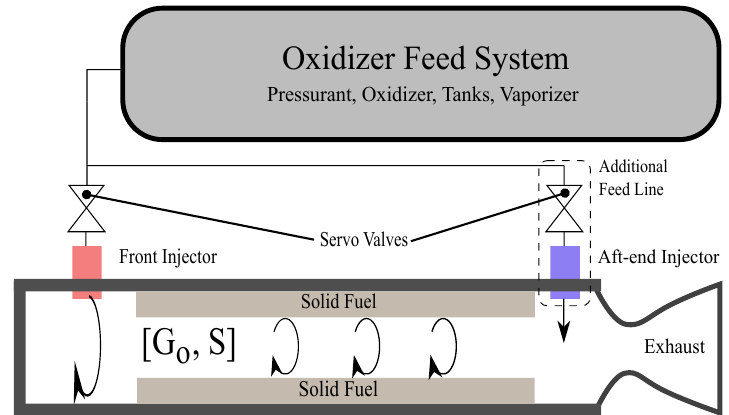
Figure 5. AOA (Aft-end Oxidizer Addition) concept with front and aft-end oxidizer